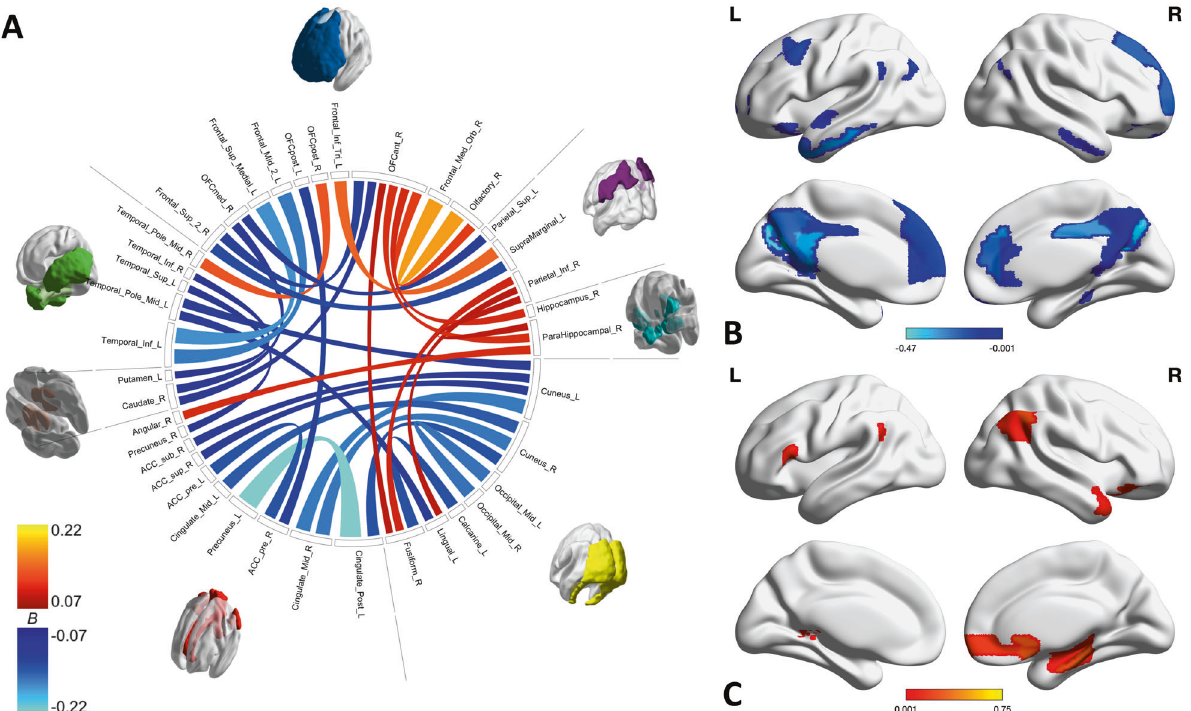
Fig. 1 Within DMN connectivities and regions associated with worry. A Chord diagram shows individual connections identi fi ed by HC with both weight and color indicating the strength of the association with worry severity (positive values/warm colors indicate stronger connectivity between regions is associated with greater worry, negative values/cool colors indicate stronger connectivity between region sis associated with less worry). B , C Brain maps show the sum of the negative ( B ) and positive ( C ) associations with worry for each region. Negative associations with worry are heavily concentrated in the bilateral ACC, PCC, and cuneus as well as the left temporal lobe. Prefrontal regions show a mix of positive and negative associations with